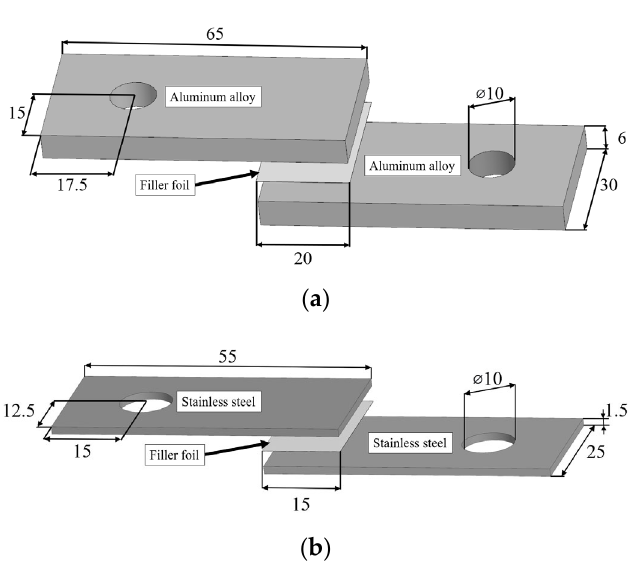
Figure 1. Brazing assembly scheme for similar materials: ( a ) AA 6082 base material; ( b ) AISI 304 base material. Values are given in